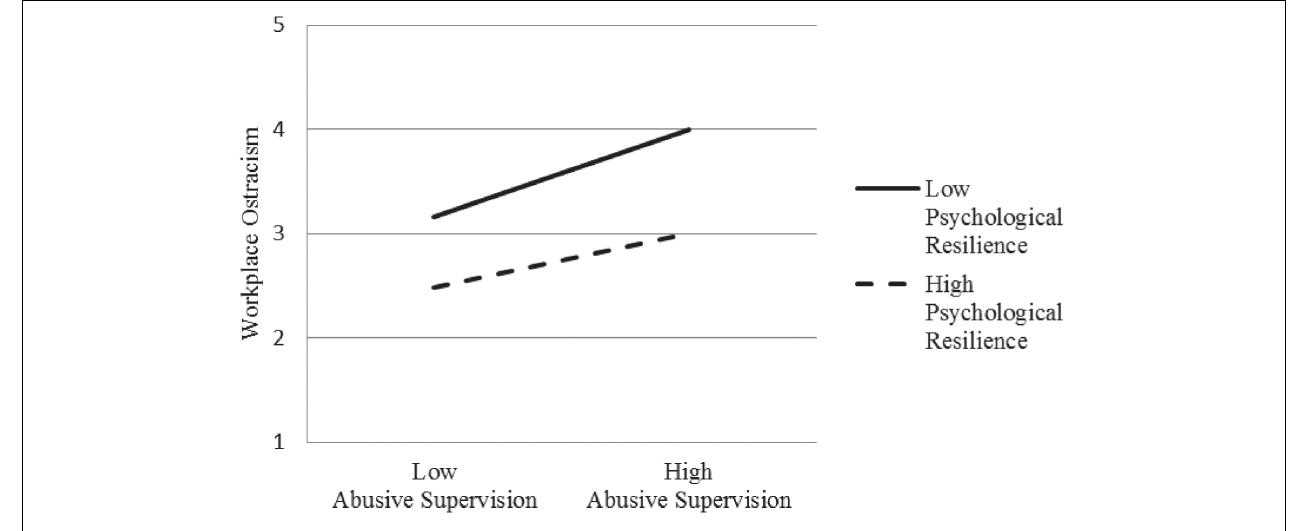
FIGURE 2 | Interaction effect of psychological resilience.